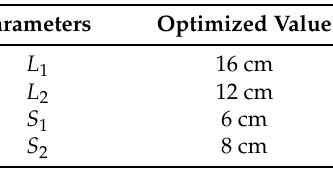
Figure 13. B_Mag. on Line 3 for shaped bars and the proposed optimum shaped bars. Table 2. Optimized bar lengths and widths for Tx and Rx